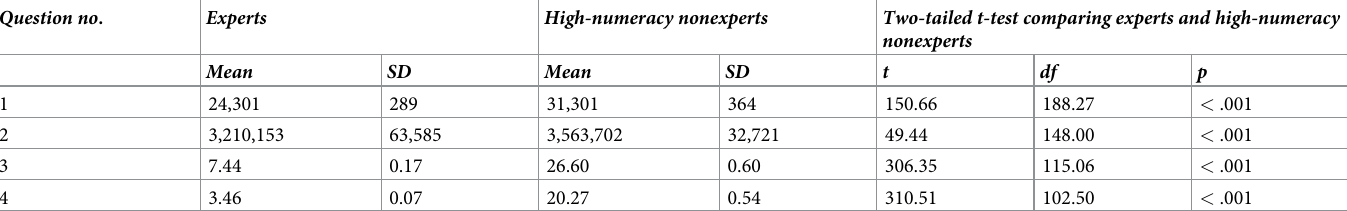
Table 3. Descriptive and inferential statistics for the sets of 100 approximate continuous ranked probability scores generated from expert and high-numeracy non- expert consensus distributions. Question no .